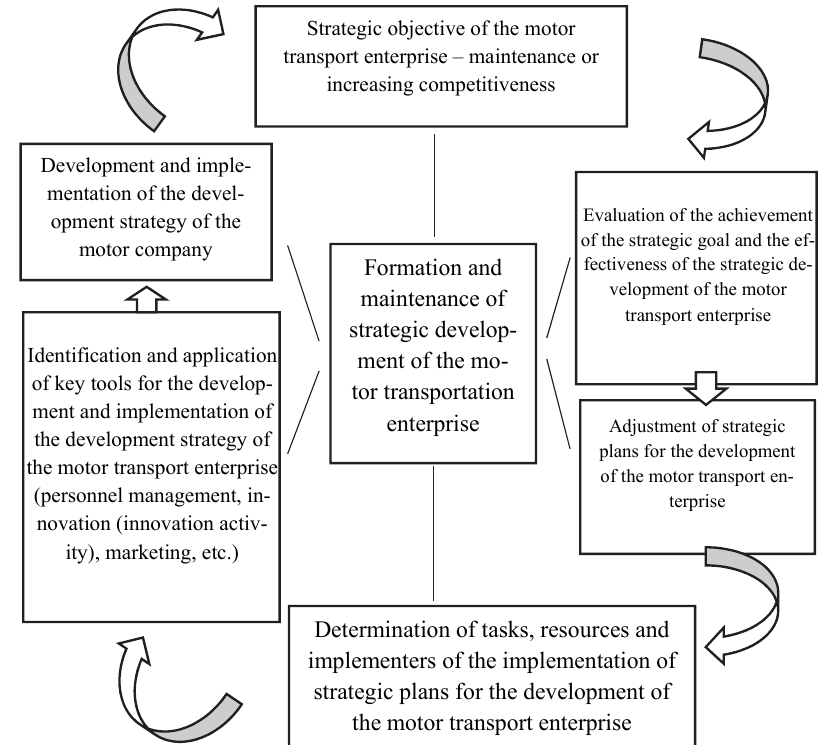
Fig. 5. Graphic interpretation of the formation and maintenance of the strategic development of the mo- tor transport